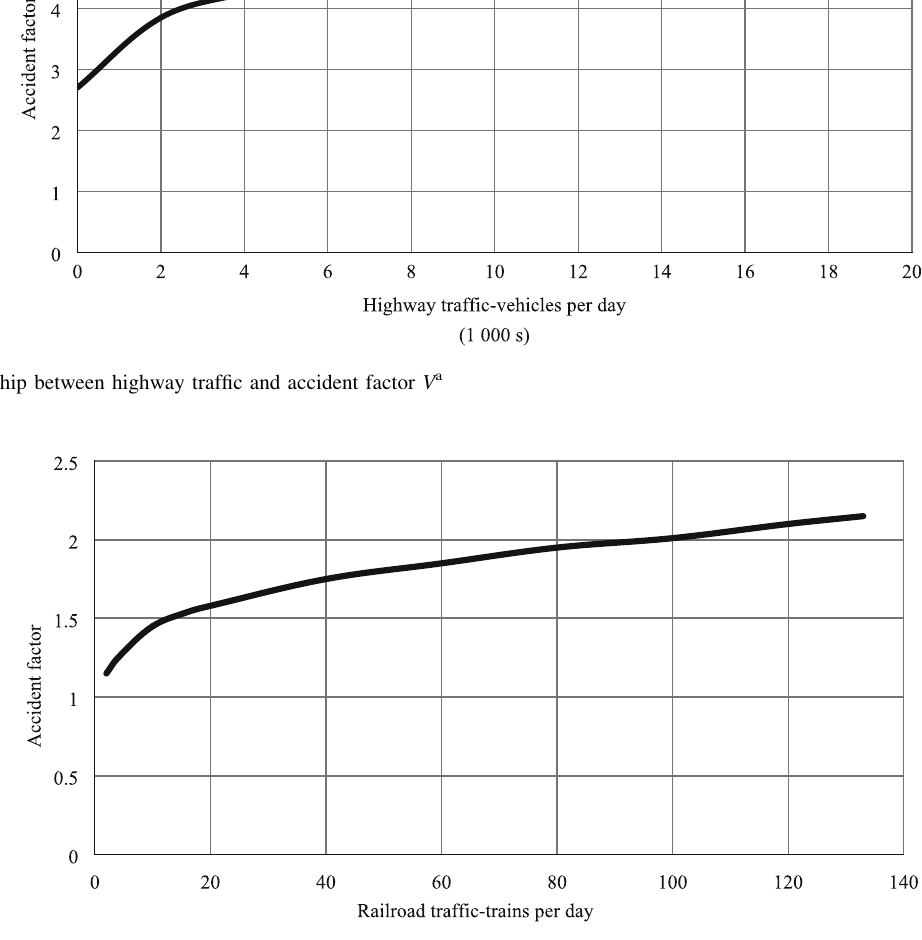
Fig. 5 Relationship between railroad traffic and accident factor T b